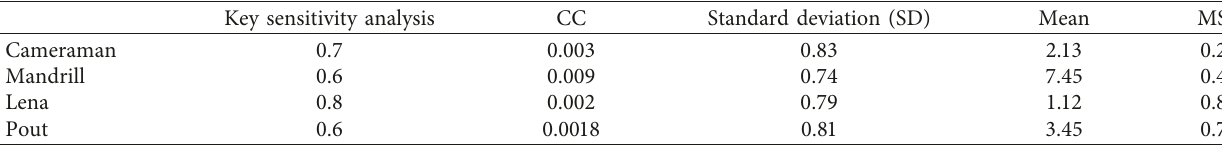
Table 4: Performance of original and encrypted image.